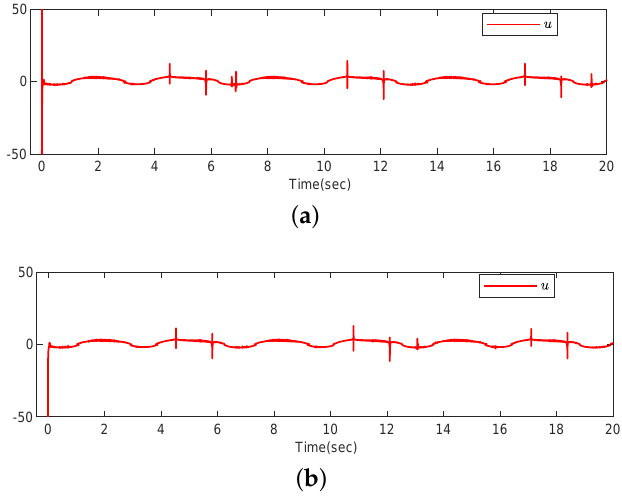
Figure 5. ( a ) Control input u under case 1 . ( b ) Control input u under case 2